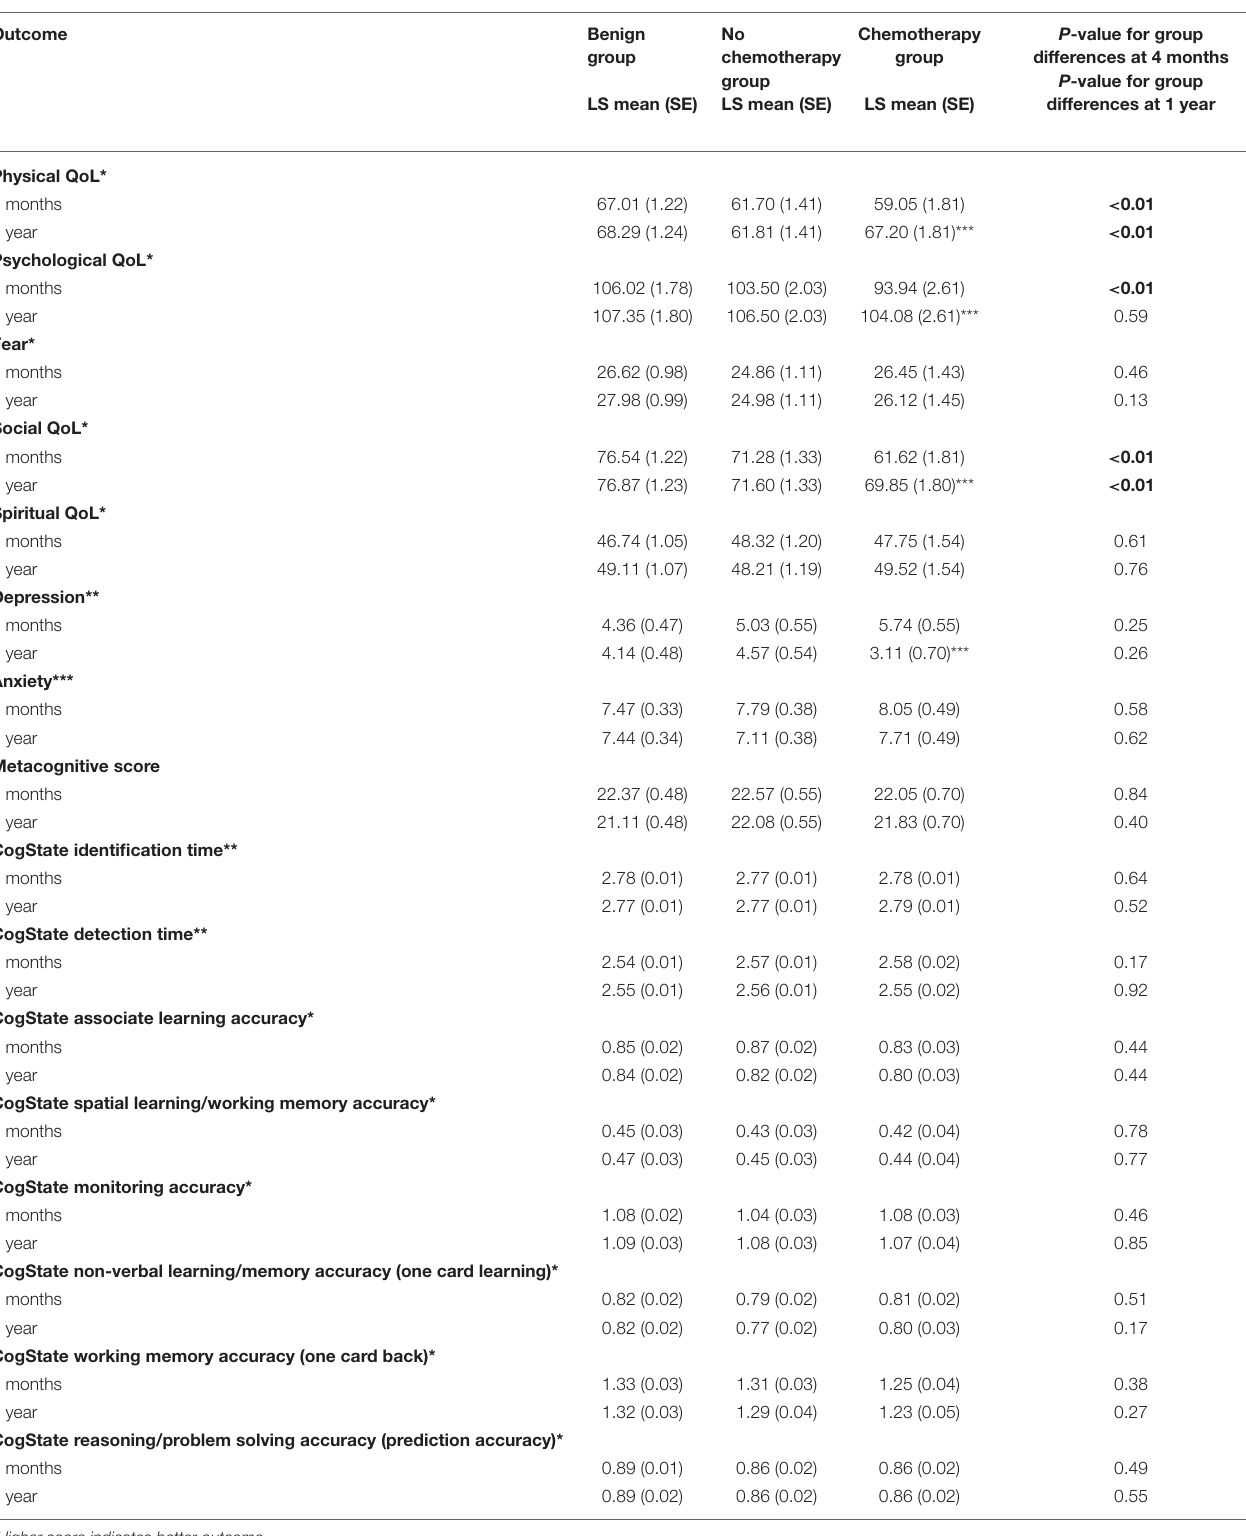
TABLE 2 | Least square (adjusted) means and SE of outcomes at 4 months and 1 year adjusted for intake, age, education, and income. Outcome Benign